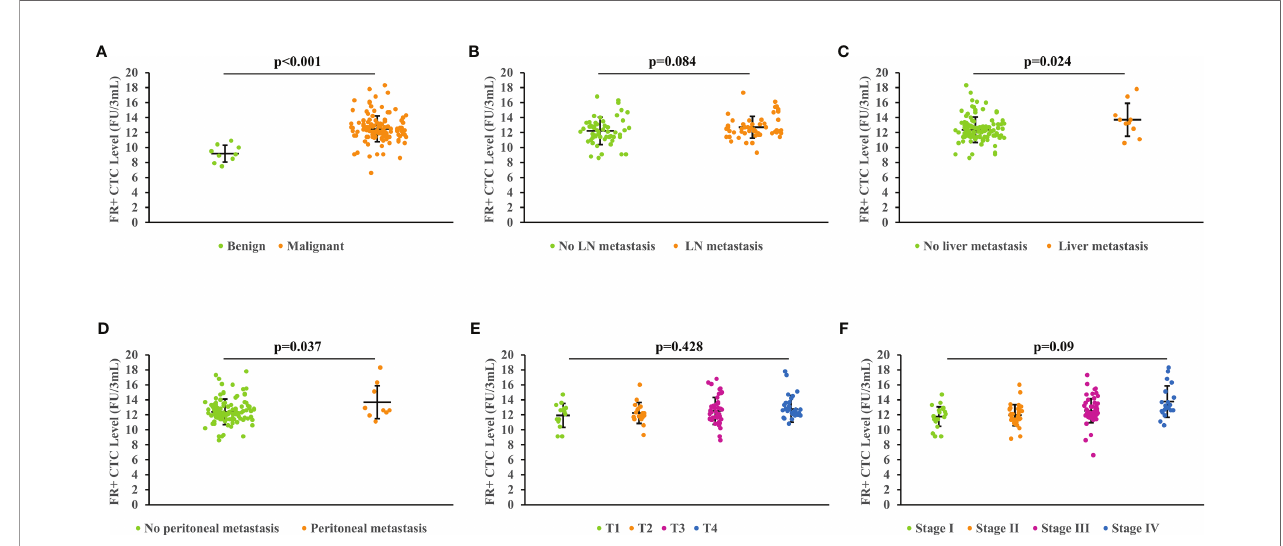
FIGURE 2 | The comparison of FR+ CTCs level based on clinical characteristics (A) Benign and malignant diseases; (B) Lymph node (LN) metastasis; (C) liver metastasis; (D) peritoneal metastasis; (E) T stage; (F) TNM stage. FR+CTCs, folate receptor-positive circulating tumor cells; T1, tumor invades the lamina propria, muscularis mucosae or submucosa; T2, tumor invades the muscularis propria; T3, tumor penetrates the subserosal connective tissues without invasion of the visceral peritoneum; T4, tumor invades the serosa or adjacent structures; TNM,